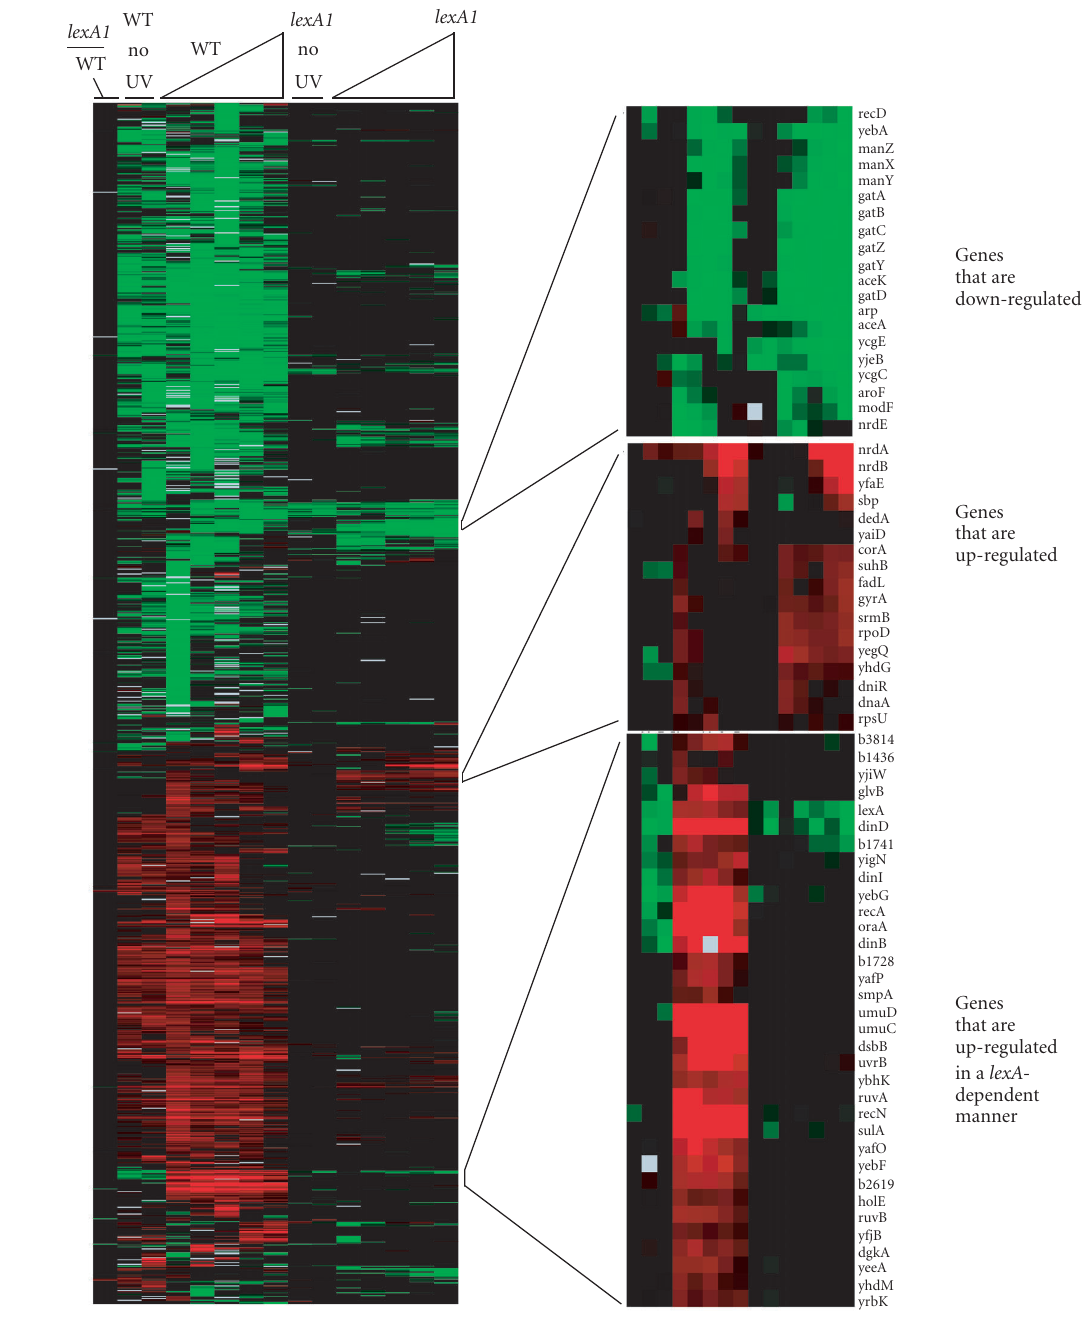
Figure 1.ClustereddisplayofgeneexpressionprofilesfollowingUVexposureinwild-typeandlexA1(SOSdeficient) Escherichiacoli [21].Increasedtranscript levels are shown in red, decreased transcript levels are shown in green. The timepoints for irradiated samples (left to right) were 5, 10, 20, 40, and 60 minutes following UV irradiation. The timepoints for unirradiated samples (left to right) were 20 and 60 minutes following UV irradiation. All measurements are relative to time 0. Genes were selected for this analysis if their expression level deviated from time 0 by at least a factor of 2 in at least 3 time points. The colored image was produced using cluster analysis and is publicly available with this data at http://genome-www.stanford.edu/UVirradiation. The color scale ranges from saturated green for log ratios 2.0 and below to saturated red for log ratios 2.0 and